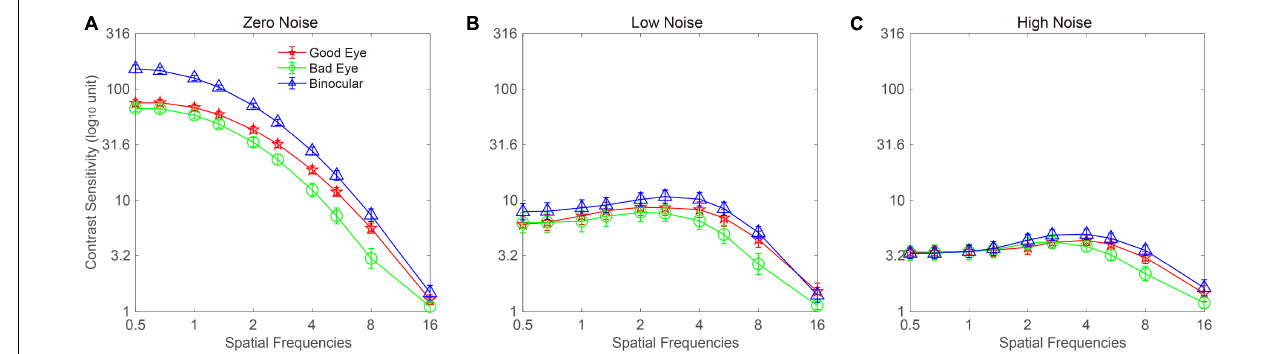
FIGURE 2 | Monocular and binocular contrast sensitivity functions (CSFs) at (A) zero-, (B) low-, and (C) high-noise levels, respectively. Red lines with pentagram symbols, green lines with circle symbols, and blue lines with triangles denote contrast sensitivity (CS) when using the good eye (GE), bad eye (BE), and two eyes (TE), respectively. Data were averaged across subjects. The error bar denotes